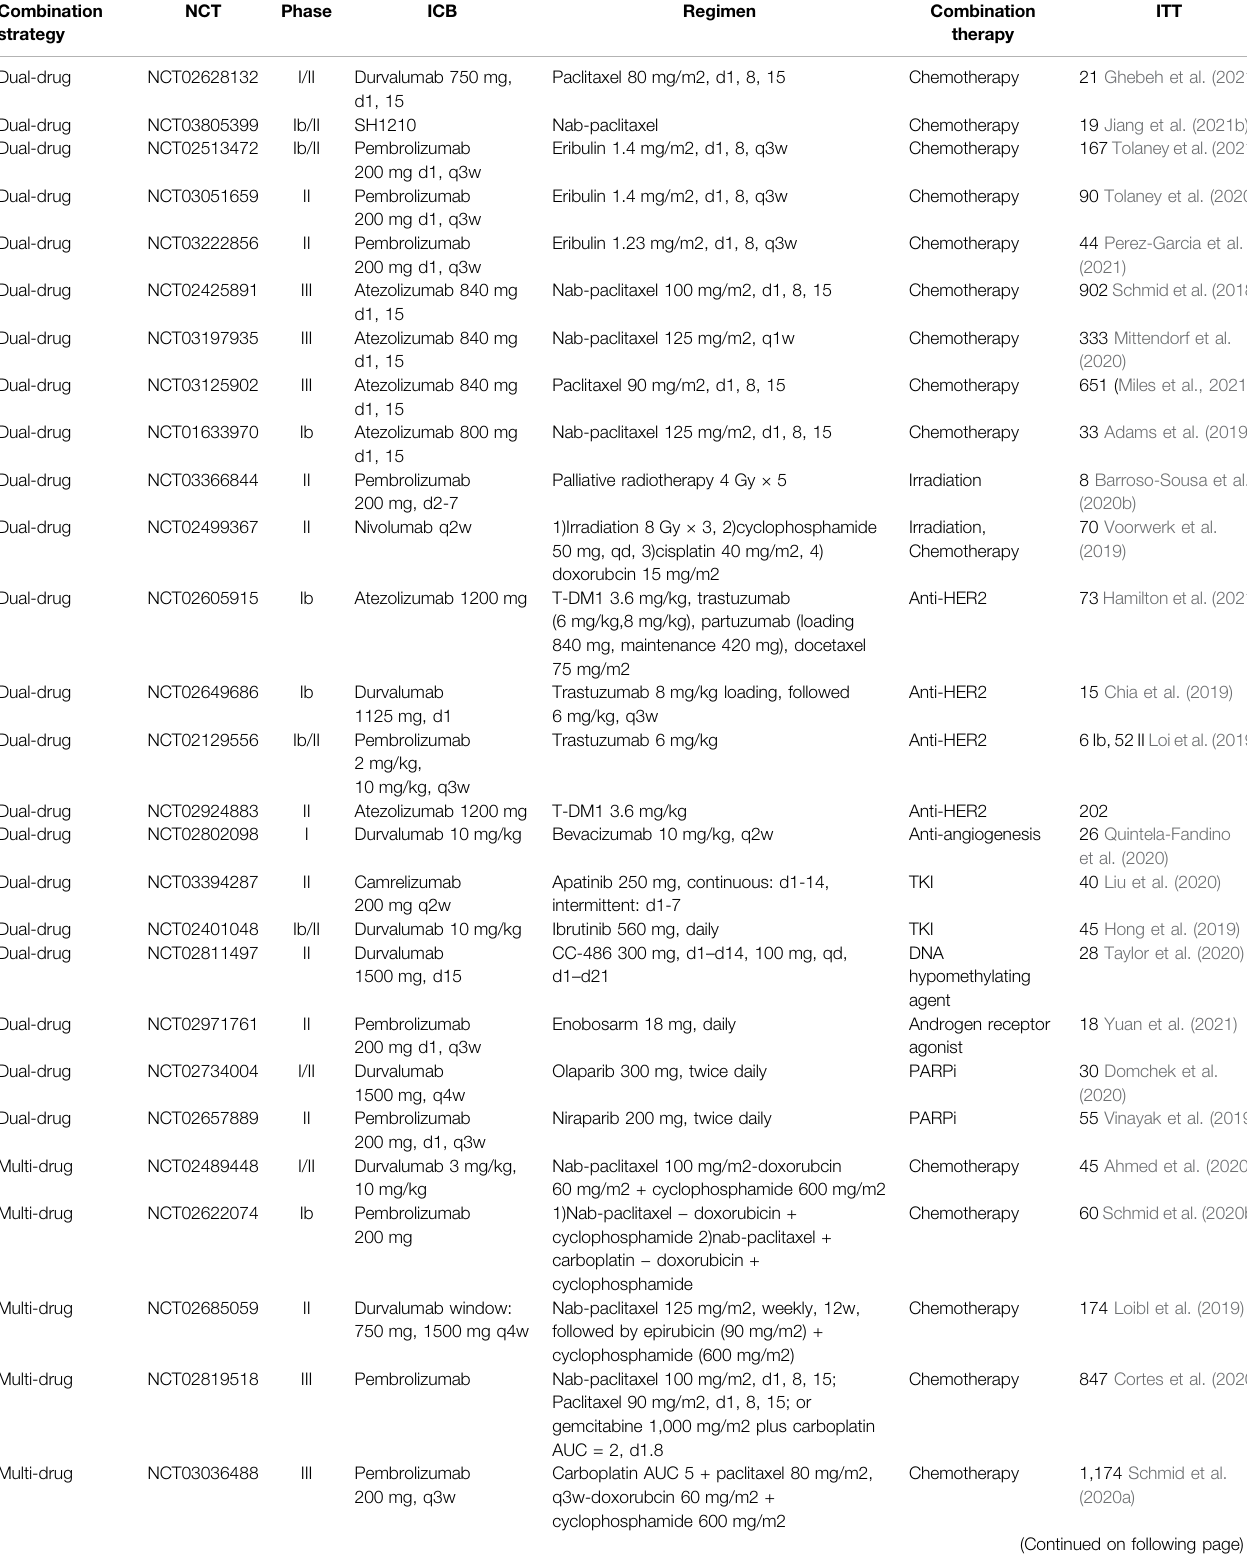
TABLE 1 | Clinical trials evaluating PD-1/PD-L1 inhibitors in combination with other therapy strategies in breast cancer. Combination